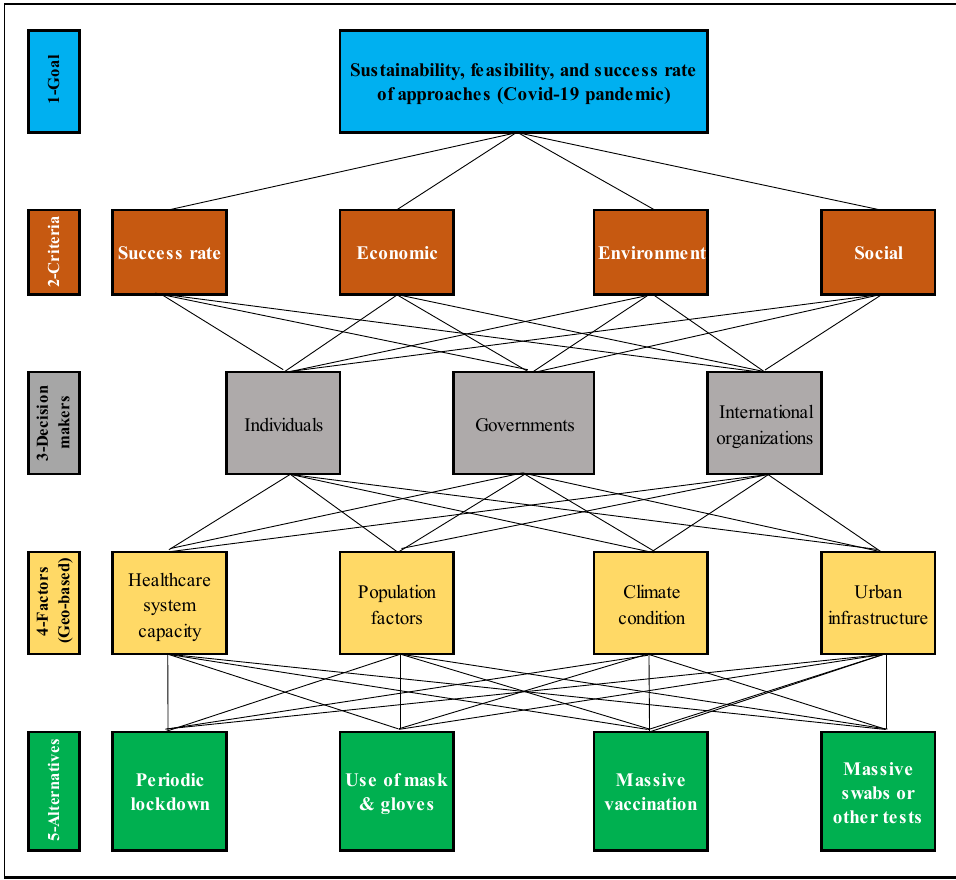
Figure 3. The developed Geo-AHP layers for ranking of approaches: COVID-19 pandemic.